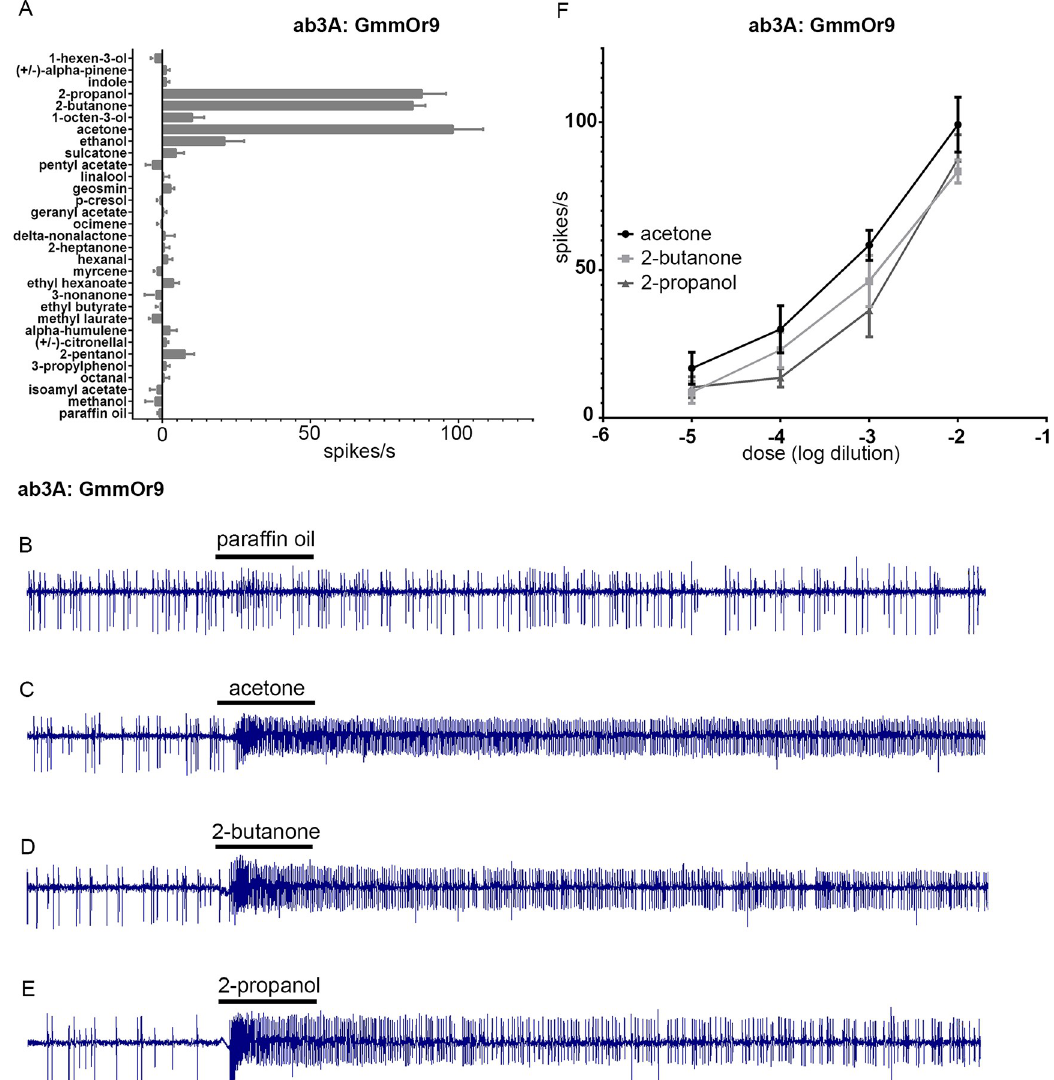
Fig 9. GmmOr9 responds strongly to 2-propanol, 2-butanone, and acetone. (A) Odorant response profile of GmmOr9 expressed in homozygous Or22ab GAL4 ab3A. (B-E) Sample traces. Black bars represent 0.5 second stimuli. (F) Dose response curves for GmmOr9. Error bars indicate +/- S.E.M. n � 5 for all stimuli